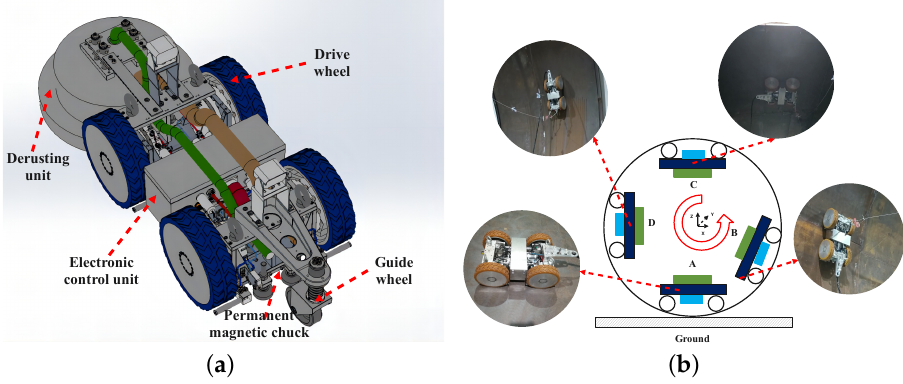
Figure 1. System composition and typical working state diagram of a wall-climbing robot. ( a ) Main components of the wall-climbing robot. ( b ) Typical motion states of wall-climbing robots inside a diversion penstock.